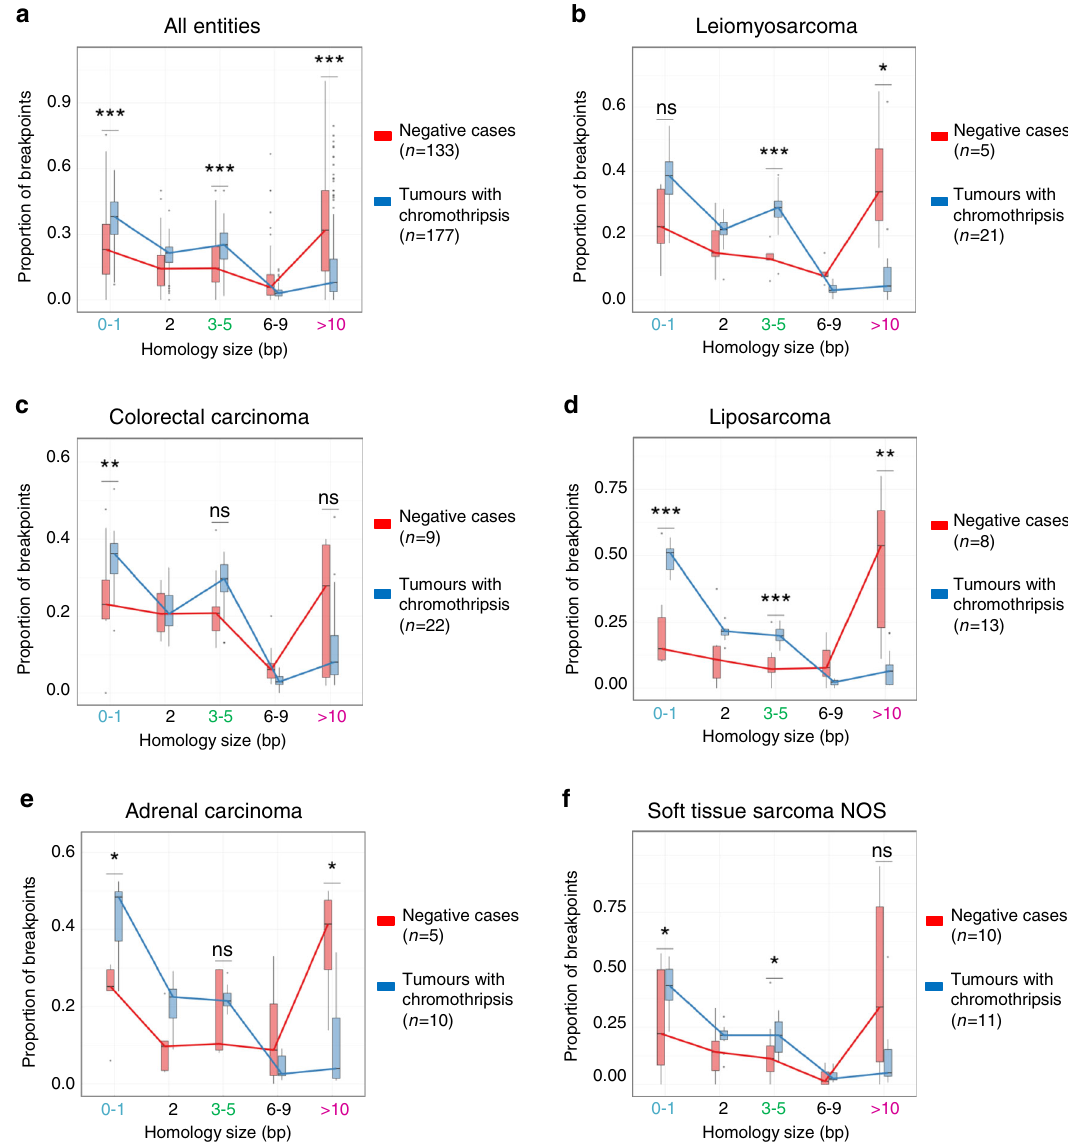
Fig. 6 Major DNA repair processes involved in the rejoining of the breakpoints after chromothripsis. Based on the number of base pairs of homology at the breakpoint sites, we can infer the prevailing repair processes involved in the rejoining of the DNA fragments ( a – f ). Statistical signi fi cance was tested using beta-regression analyses. Family-wise correction of p values was performed according to Bonferroni for all tumour entities with at least 15 cases in total, of which at least 5 tumours showed chromothripsis and at least 5 were negative. The comparisons shown here were performed case wise (tumours with versus without chromothripsis). Comparisons performed region wise (chromothriptic chromosomes versus non-chromothriptic chromosomes) are shown in Supplementary Fig. 6. Centre lines show median values, bounds of boxes show 75th percentiles and whiskers show maximum and minimum. (* p < 0.05; ** p < 0.01; *** p <